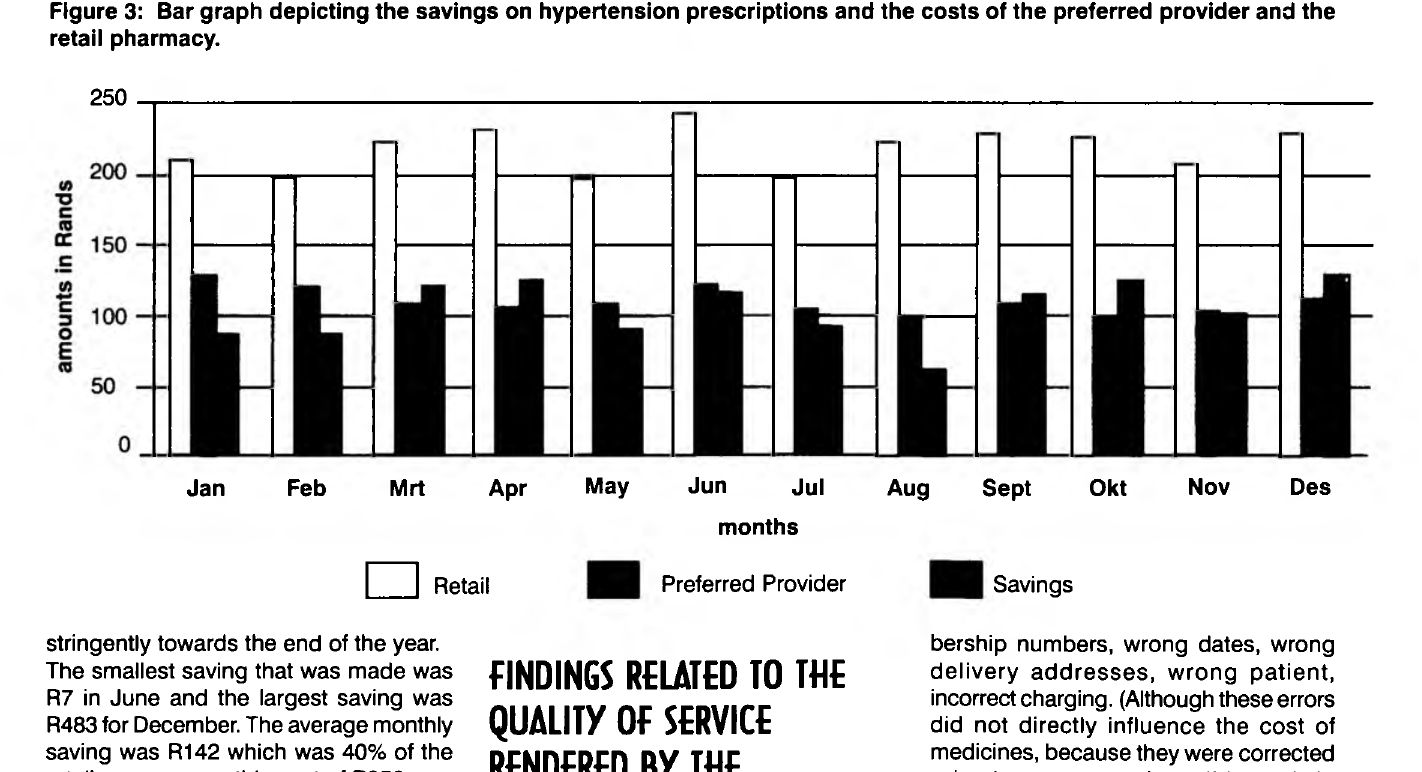
Figure 3: Bar graph depicting the savings on hypertension prescriptions and the costs of the preferred provider and the retail pharmacy.